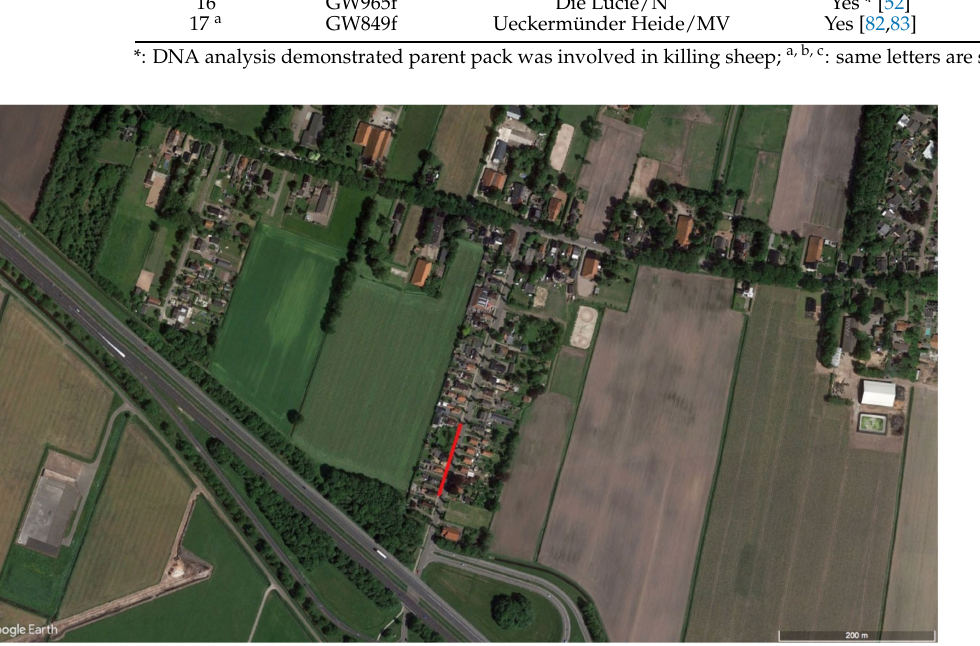
Figure 1. Satellite image overviewing the village Kolham and the trajectory (in red) from south to north of wolf 1 when filmed. Image: ©Google